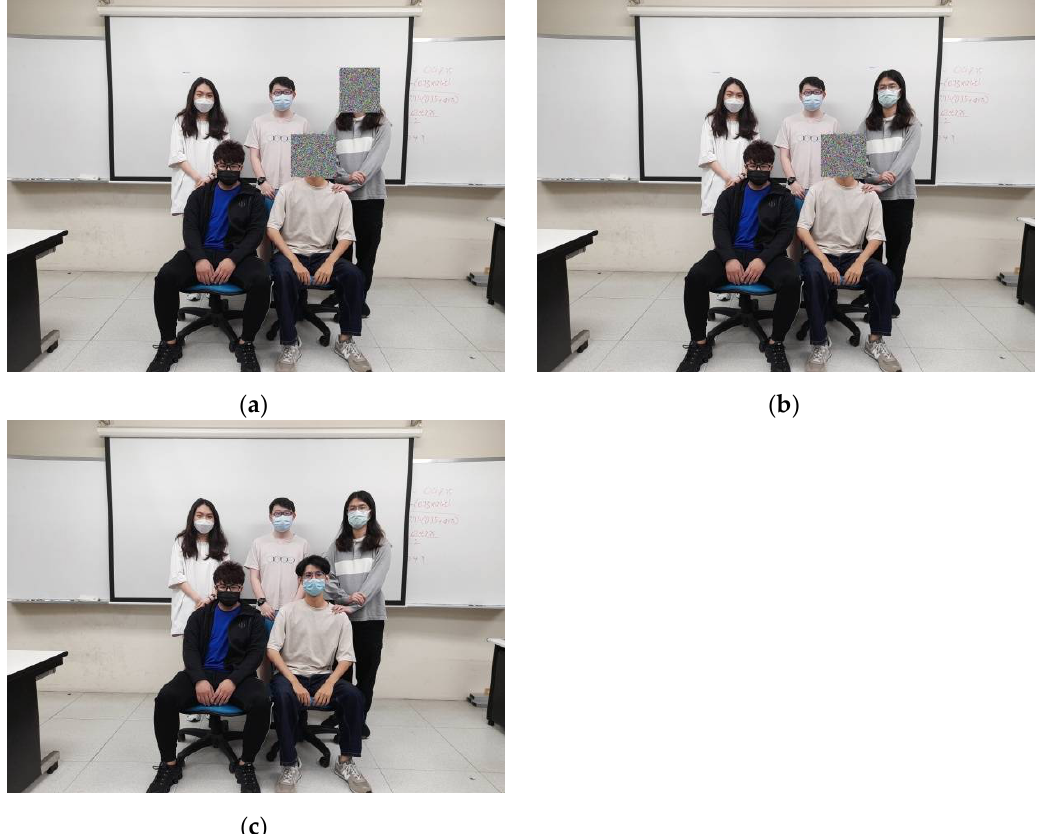
Figure 6. Images of accessible classes C 1 , C 2 , and C 3 decrypted by SK 1 , SK 2 , and SK 3 , respectively.